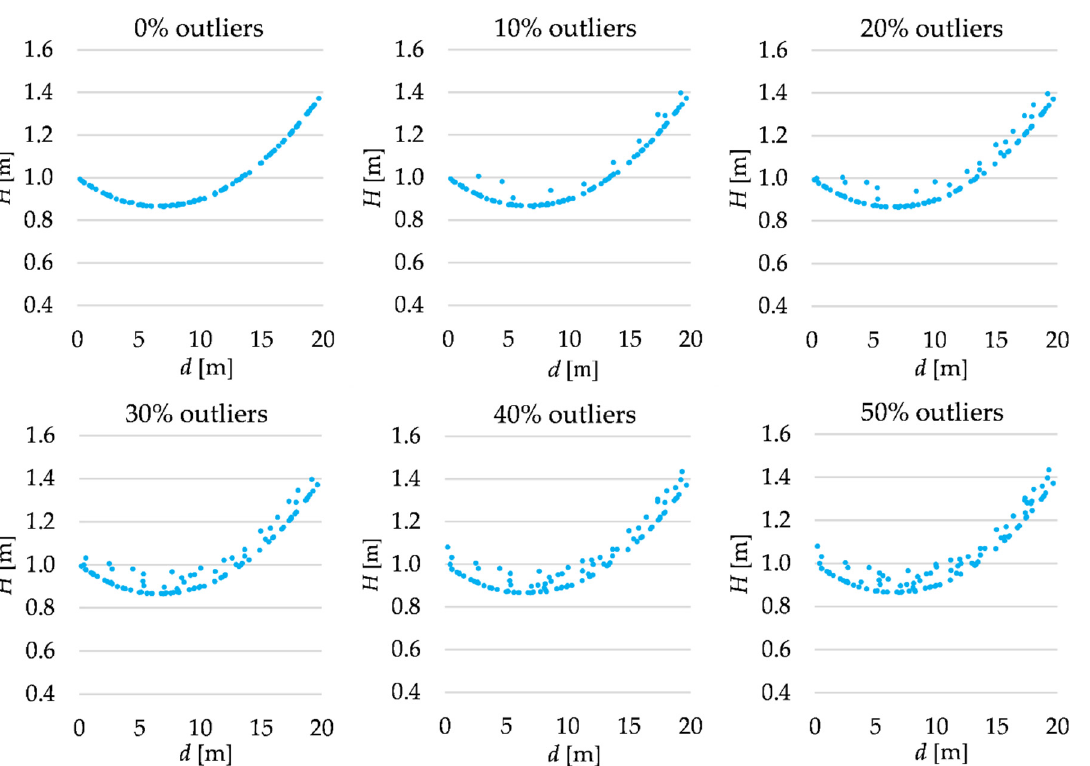
Figure 2. Simulated observation set (third-degree polynomial).